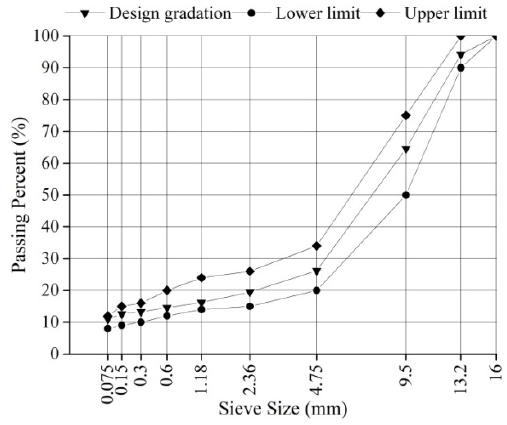
Figure 2. Gradation of SMA-13.